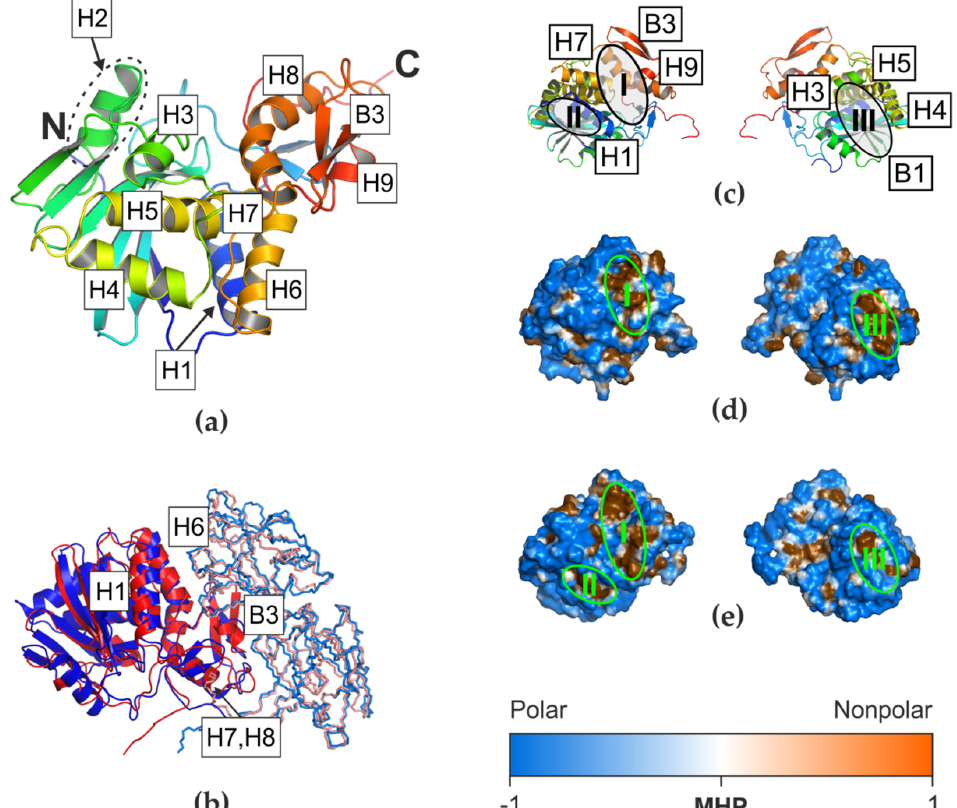
Figure 2. Comparison of the structural and surface properties of RTA and MLA. ( a ) Ribbon representation of RTA with marked secondary structure elements. ( b ) Structural superposition of ricin (blue) and viscumin (red). The catalytic A and cell-binding B subunits of the toxins are given in the cartoon and ribbon representation, respectively. B subunits are shown to illustrate the positioning of the A/B dimerization interface. Structural elements of the chain A participating in the contact are signed. ( c ) Location of nonpolar surface regions in RTA. The three largest hydrophobic clusters—I, II, and III—are encircled by ellipses. Structural elements participating in the cluster formation are marked. ( d , e ) Hydrophobic properties of the RTA and MLA surfaces, respectively. Three main nonpolar regions—hydrophobic clusters I, II, and III—are highlighted by green ellipses.